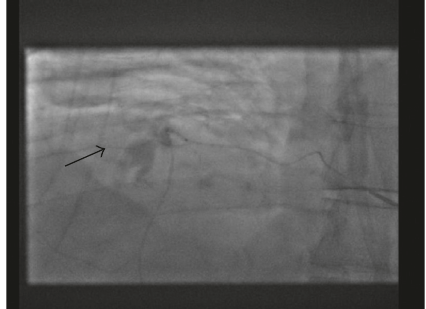
Figure 3: X-ray angiogram of the intercostal arteries shows active contrast extravasation (arrow) from the right T7 intercostal artery.